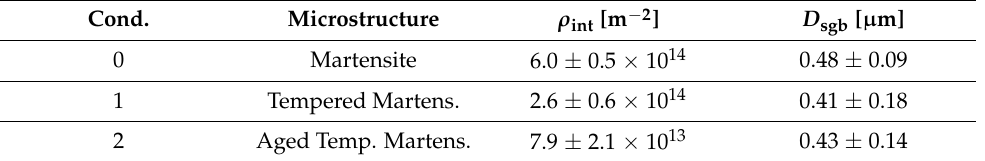
Table 6. Dislocation densities and subgrain sizes from Z6 TEM analysis.